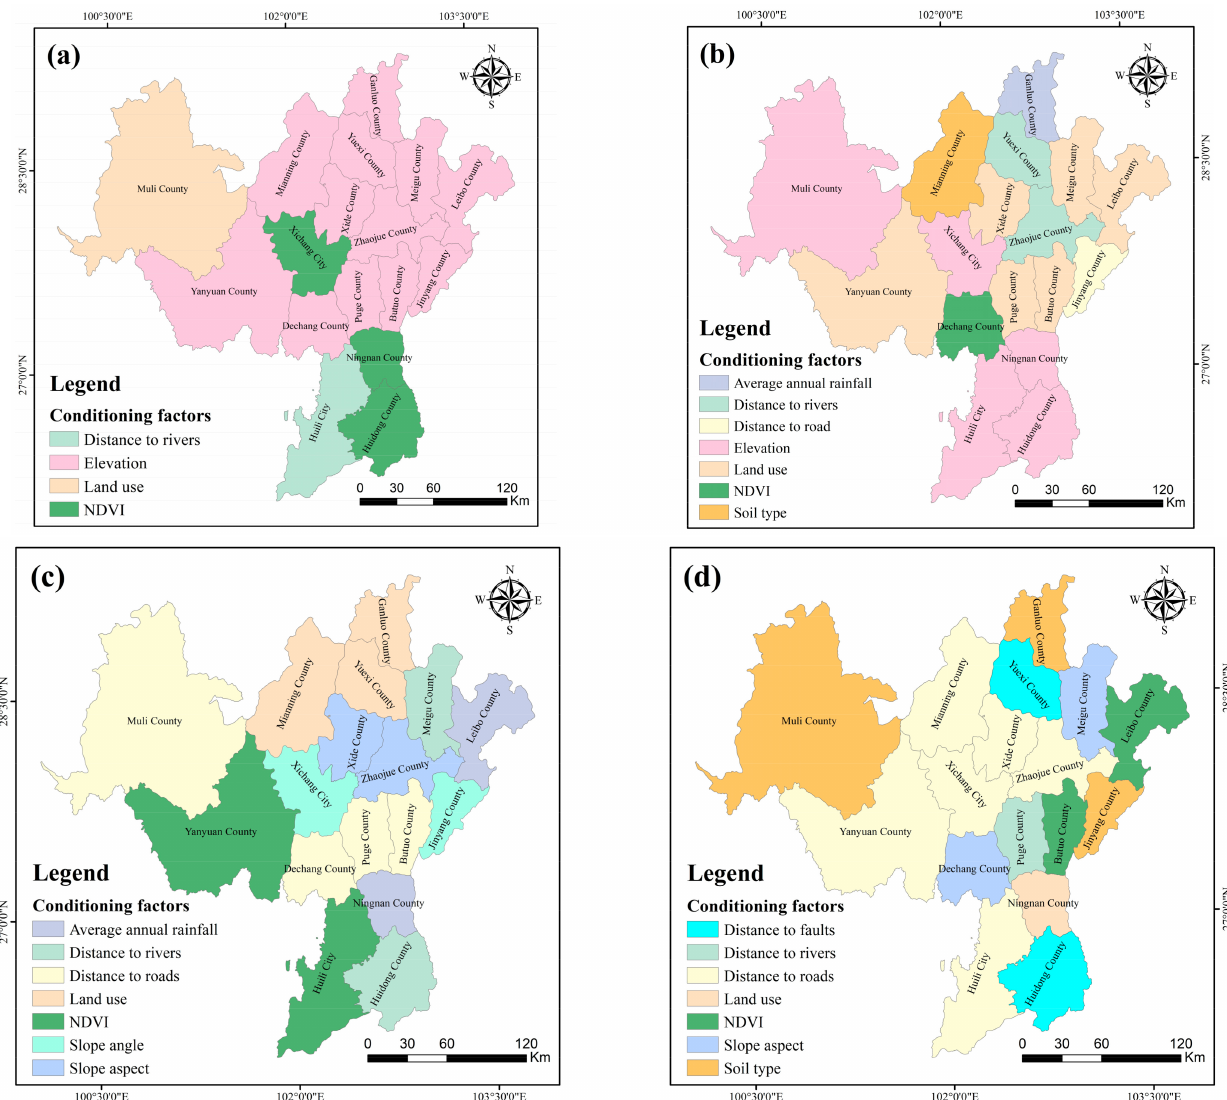
Figure 8. The four most important features at the county level: ( a ) first feature ranking; ( b ) second feature ranking; ( c ) third feature ranking; ( d ) fourth feature